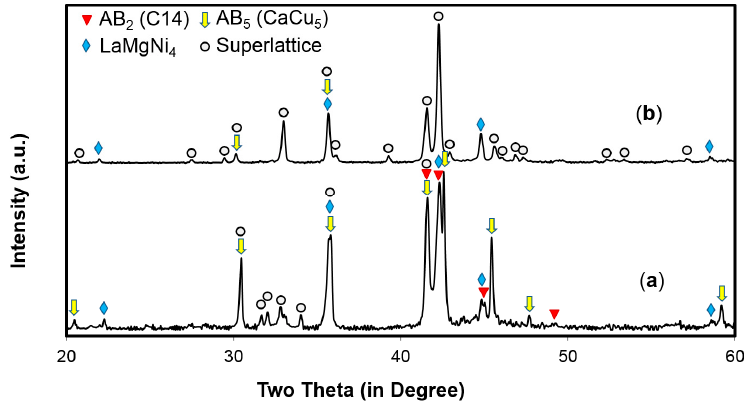
Figure 1. X-ray diffractometer (XRD) patterns using Cu-K α as the radiation source for ( a ) pristine, and ( b ) annealed alloy B.